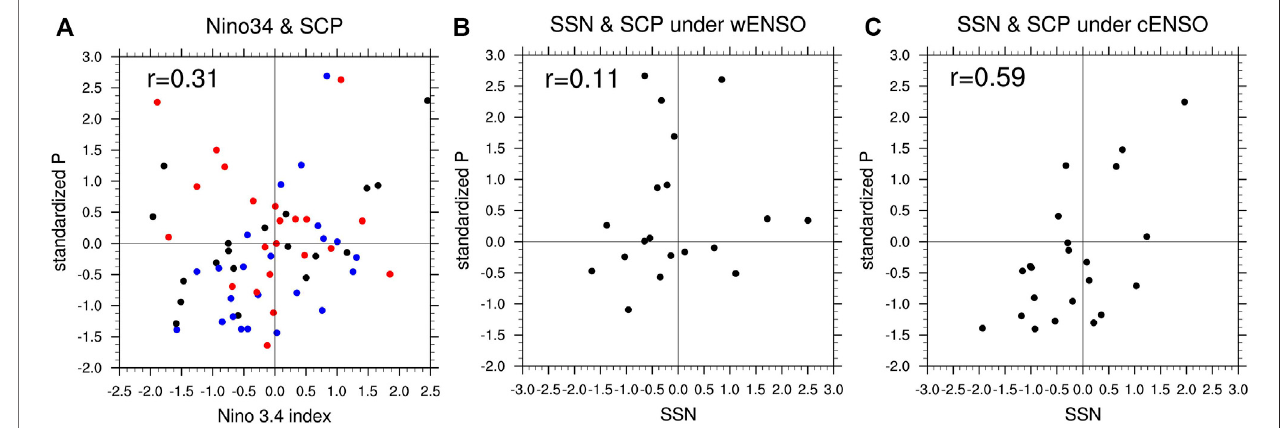
FIGURE5| panel (A) showsscatterplotofstandardizedprecipitationanomaliesagainstNiño3.4index.Red(blue)dotsdenoteHS(LS)phase,respectively.panels (B) , (C) show scatter plots of standardized precipitation anomalies against SSN under wENSO and cENSO phase,